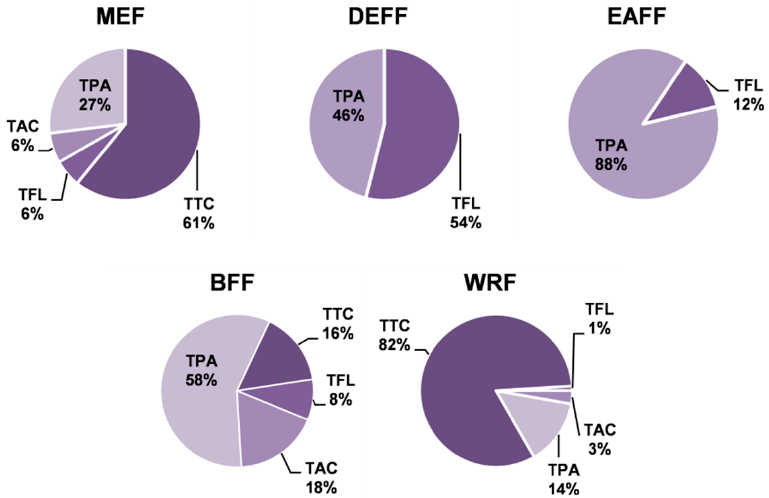
Figure 2. Contribution of individual groups of compounds to total phenolic contents in P. spinosa fruit extracts. TPA, TAC, and TFL: total contents of phenolic acids, anthocyanins, and flavonoids, respectively, determined by HPLC-PDA; TTC: total content of condensed tannins in procyanidin B2 (PB2) equivalents. For extracts codes, see Table 1.